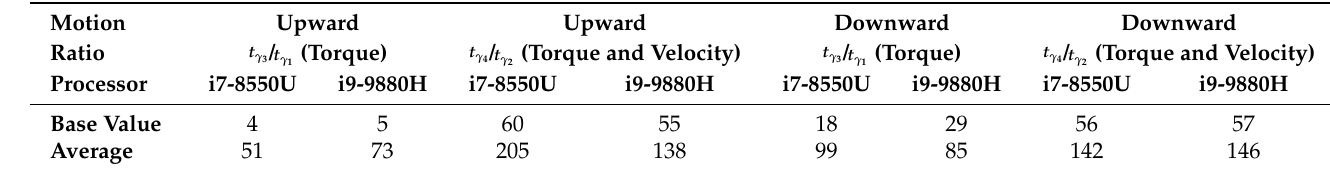
Table 2. NDSolve computing time decrease factor: ratio between comparable running cost functions. The decrease in computing time resulting from our invariant running cost functions γ 1 and γ 2 is noticeable.